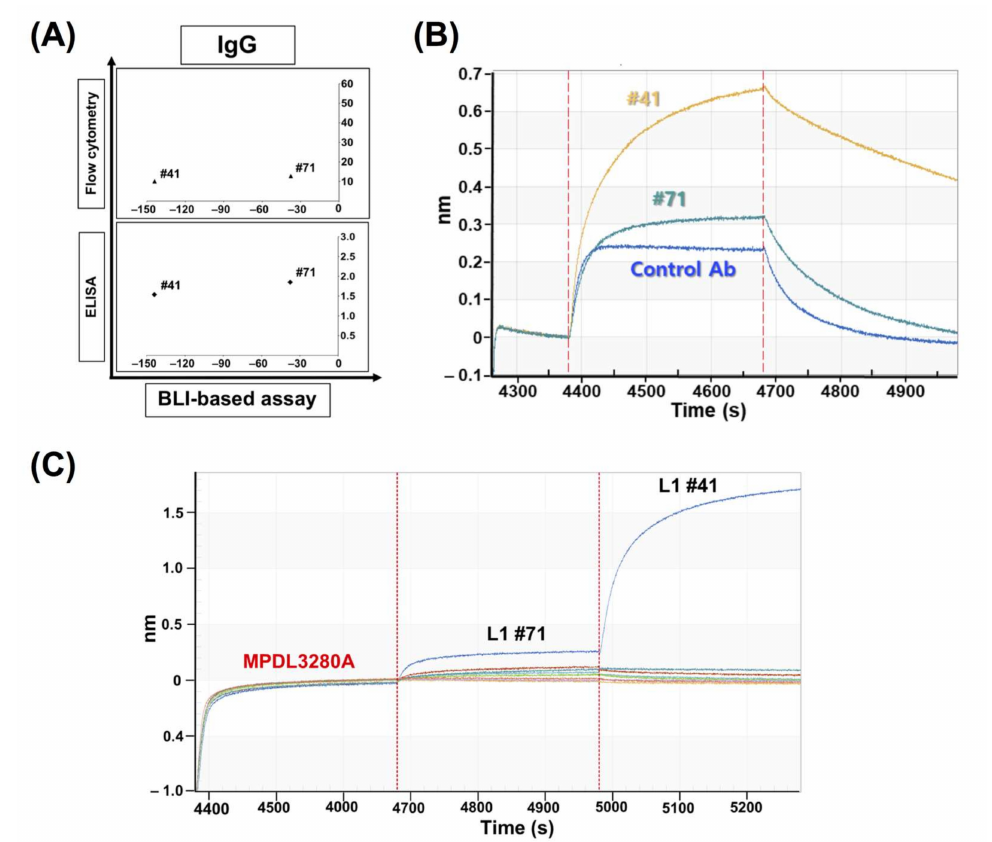
Figure 7. The application of the BLI-based assay for epitope characterization of antibodies. ( A ) Classification and assessment of abnormal binding sensorgrams in BLI-based PD-1 / PD-L1-binding inhibition assays. In the assay, PD-1 is coated on the sensor and a mixture of PD-L1 and each IgG antibody clone was incubated with the sensor; ( B ) Distribution of #41 (-144%) and #71 (-37.63%) clones in BLI-based assays using IgG; ( C ) Binding compatibility test using the BLI assay. The PD-L1-coated sensors were pre-saturated with MPDL3280A antibody binding and two antibodies were introduced to the sensors consecutively to check if any clone has compatible binding with MPDL3280A (tested clones: #3, 6, 10, 24, 26, 29, 35, 40, 41, 50, 51, 52, 56, 63, 70,